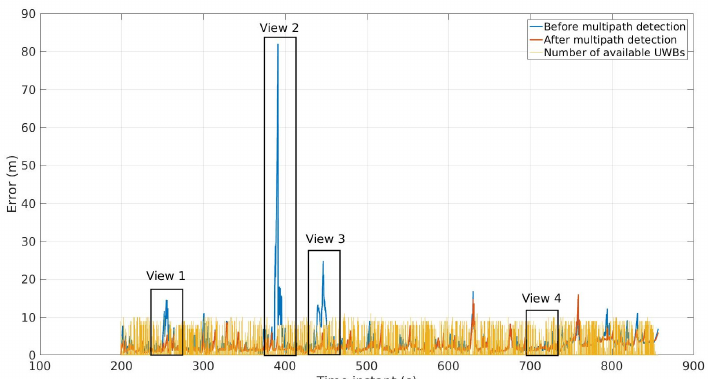
Figure 17. Plot of localization error overlaid with number of available UWBs for the first experiment.